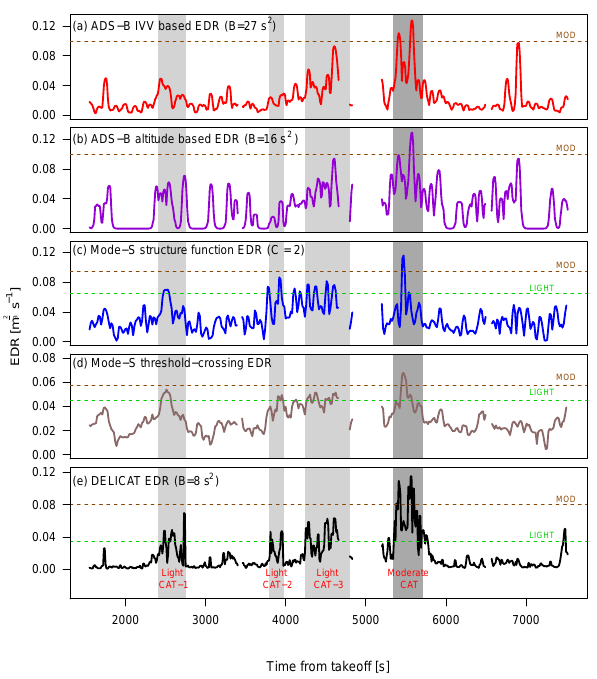
Figure 6. Results for FL9 for all analysed approaches to estimate EDR and a reference EDR (as in Fig. 2). The time series are scaled to match the intensity of the MOD event. For reference the indica- tive turbulence levels have been added to the plot. Those are reflect- ing the FL9 encounters and levels of noise inferred from the calm flights.